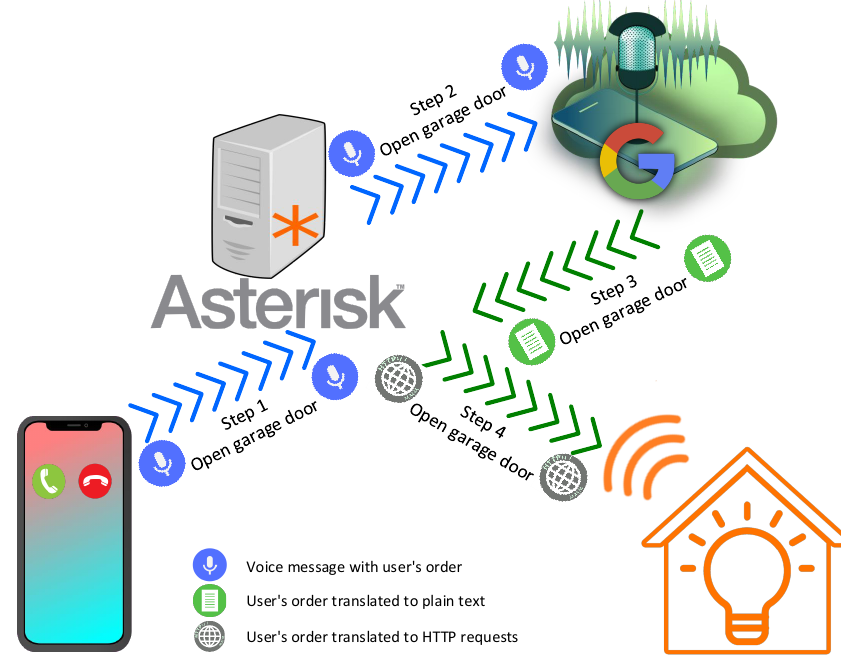
Figure 3. Architecture of the projects to manipulate an IoT Smart